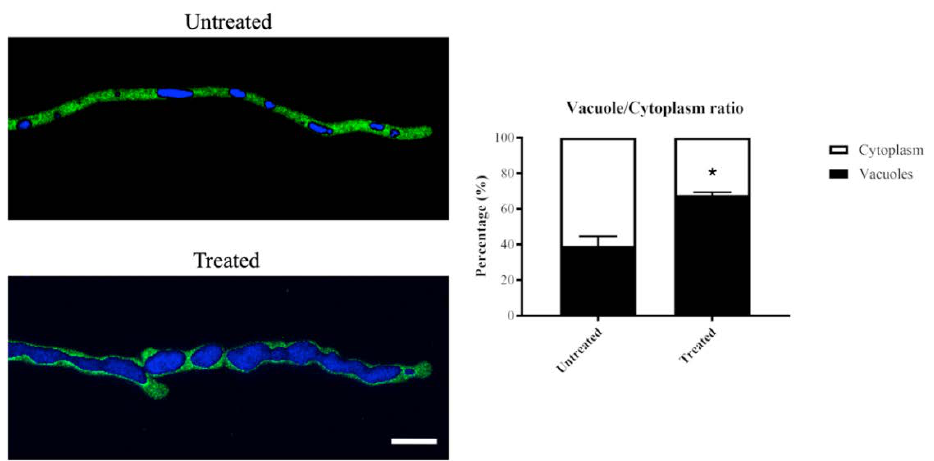
Figure 5. Vacuolar volume increases in 24 h olorofim-treated hyphae. Vacuoles in a cytoplasmic-GFP strain were stained with CMAC and the vacuole / cytoplasm ratio was measured. Vacuolar volume was significantly enlarged after exposure to olorofim, resulting in a reduced cytoplasmic volume. Scale bar = 10 µm. Error bars represent SD. * p < 0.01.